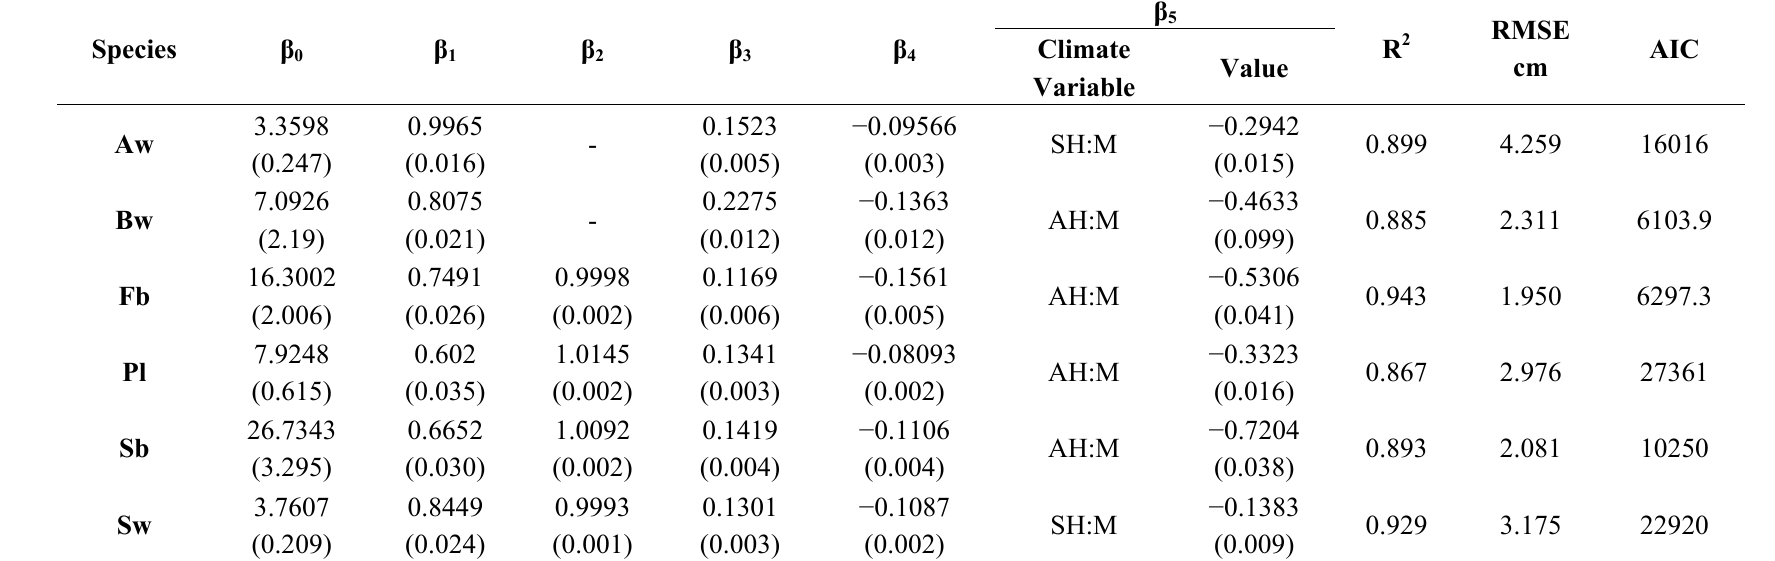
Table 6. Parameters estimates (reported with standard errors) and goodness-of-fit for tree diameter modeled as a function of height, crown area, basal area of the larger trees and climate, for trembling aspen and white birch, Equation (10); and for balsam fir, Equation (11), as described in Section